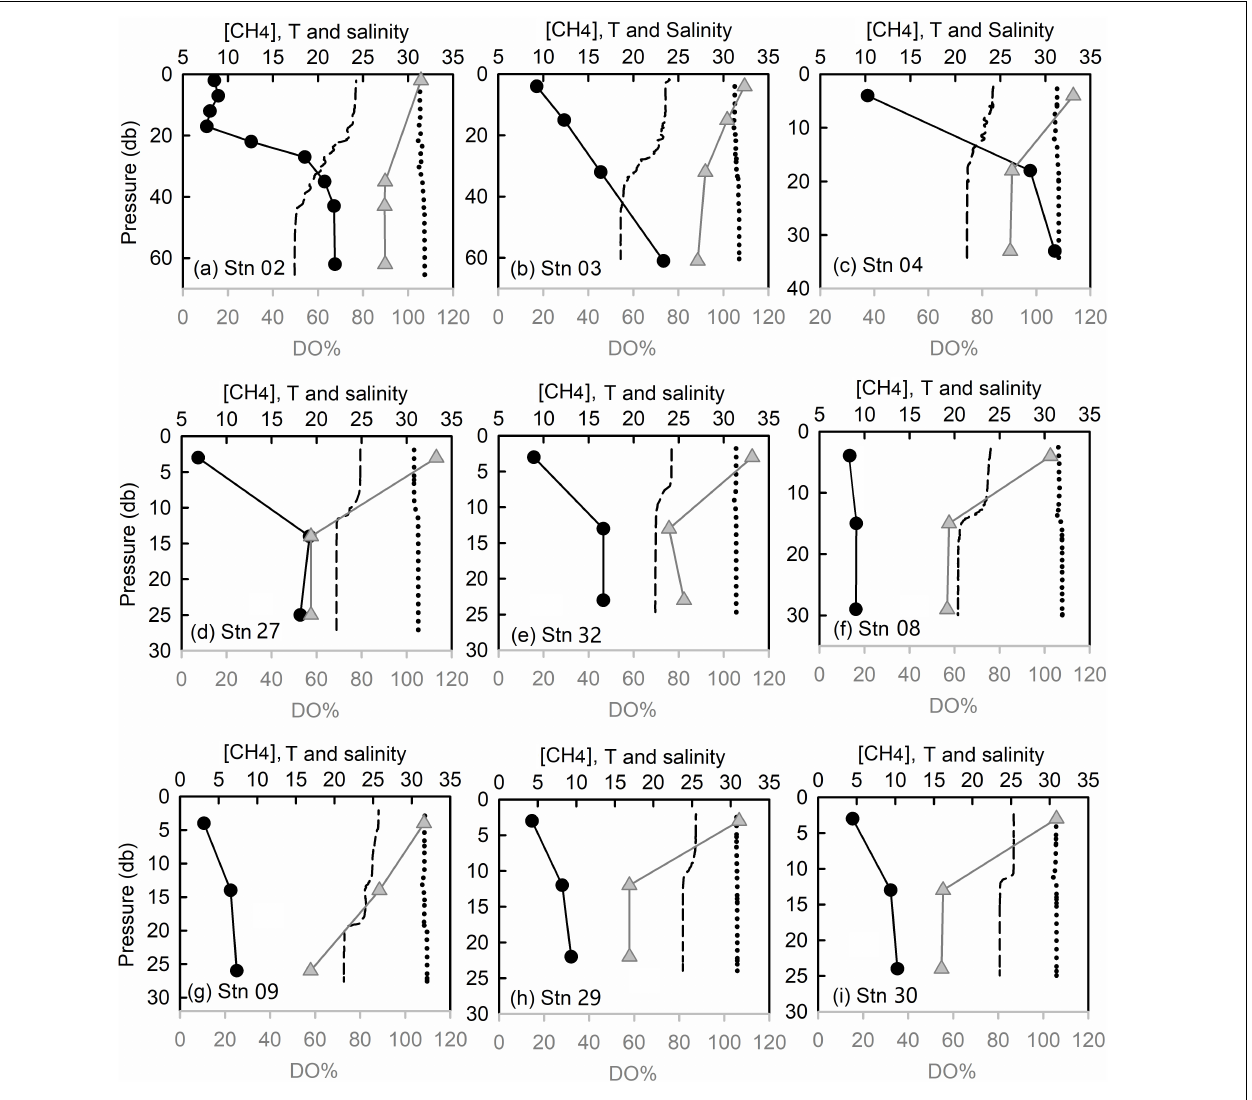
FIGURE 3 | Profiles of [CH 4 ] (nmol kg - 1 , filled circles in black), DO% (filled triangles in gray), temperature ( ◦ C, dashed lines), and salinity (dotted lines) in the Laotieshan Channel (a–c) , the oil/gas spill areas (d–e) , and the DO deficit areas (f–i) .